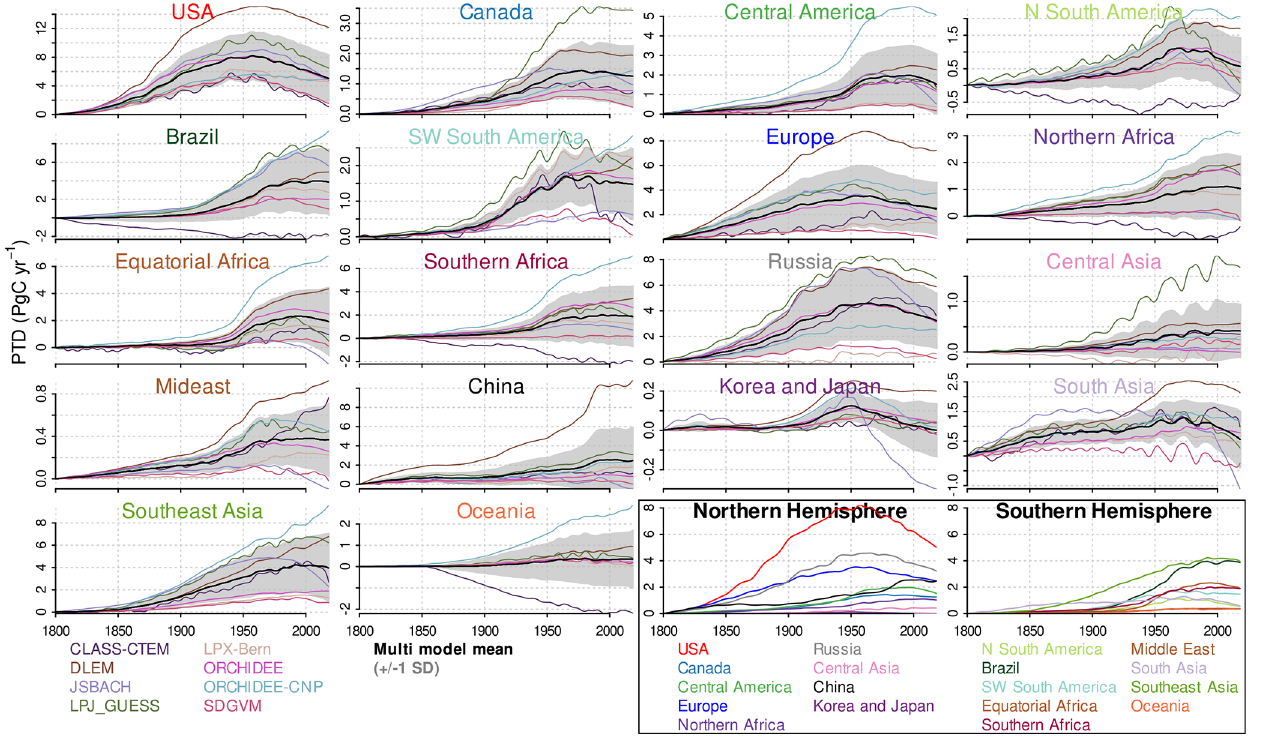
Figure A11. Region-wise smoothed cumulative “present-day” vs. “transient” environmental conditions difference in the f LULCC (PTD) from 1800 onward (compare Eq. 5). The PTD was not derived for CLM5.0, JULS, LPJ, and OCN models (compare Table 2). For a discussion of individual models refer to Sect. A1. The last two panels show regional ensemble means on a uniform